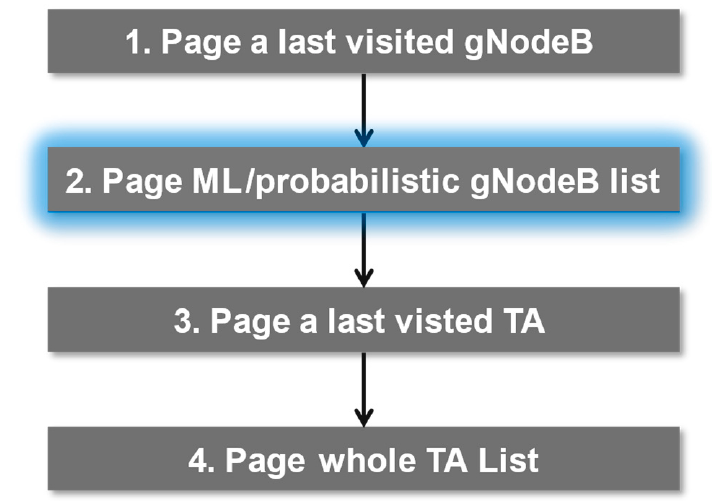
Figure 7. Proposed AMF paging range profile.